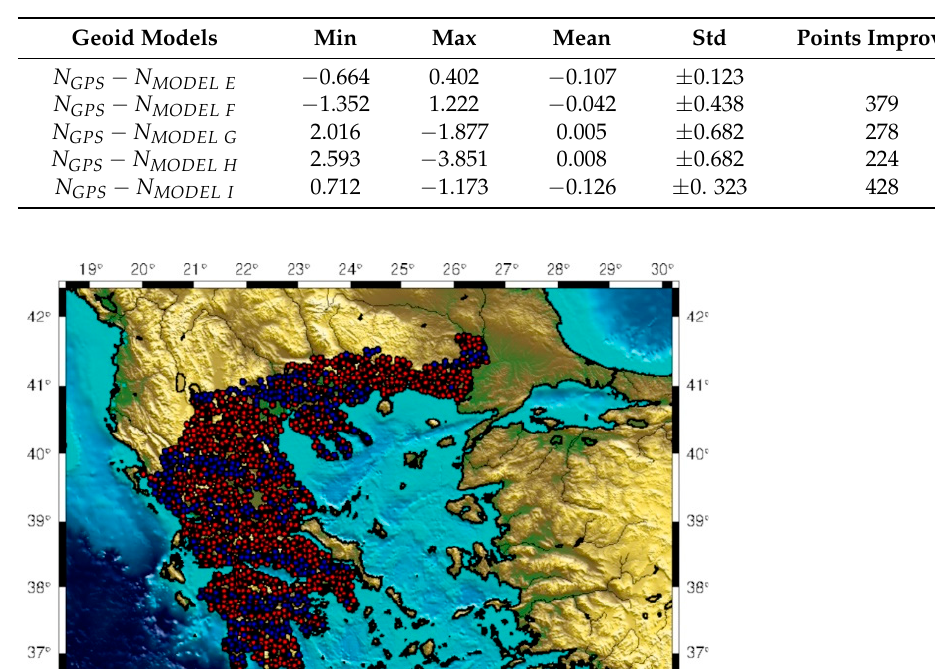
Table 8. Statistics of geoid height differences between the GNSS/leveling data and the FFT geoid models. Units: (m).